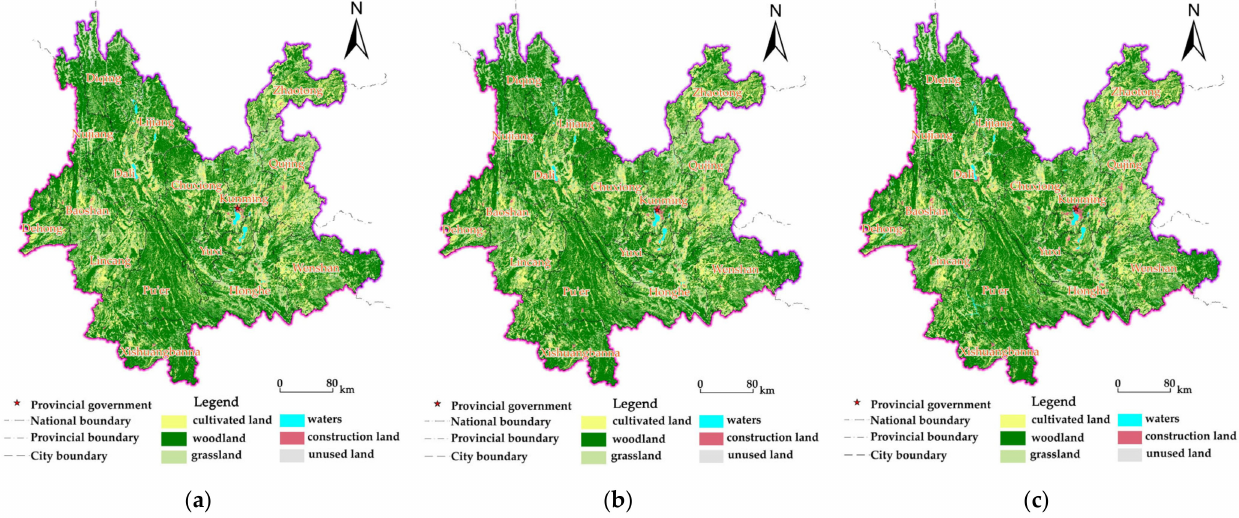
Figure 3. Land use/land cover maps of Yunnan Province: ( a ) 2000; ( b ) 2010; ( c )